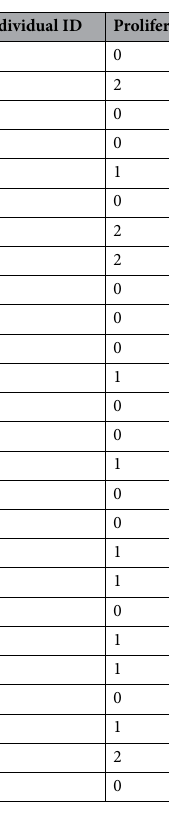
Table 2. The proportions of proliferating/stem MMc cells (clusters 14) and the other cell types in individual embryos. The proportions of the proliferating/stem MMc cells were significantly different among the embryos (p-value = 0.03976, Fisher’s test,